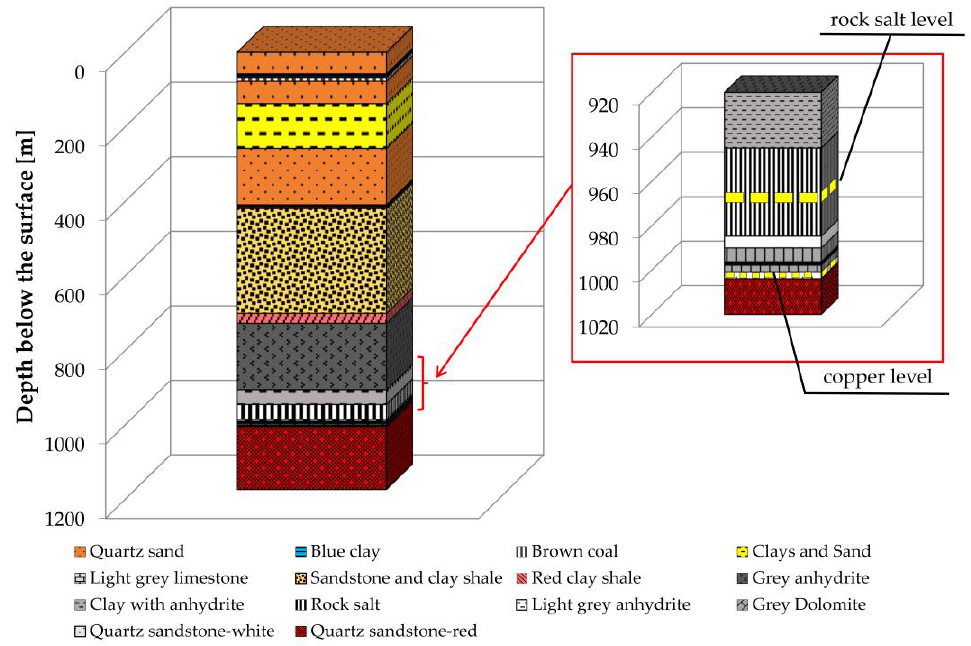
Figure 1. Stratigraphic profile within the analyzed area.